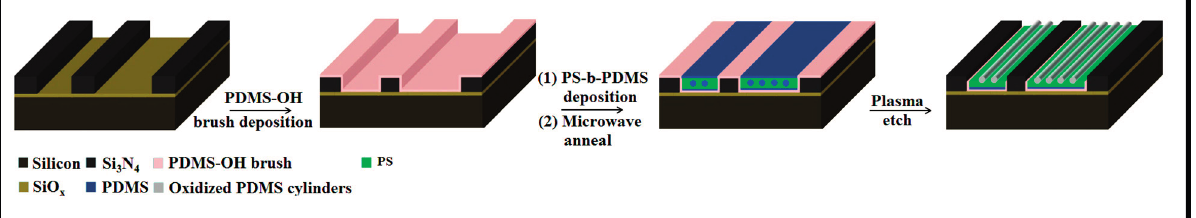
Scheme 2. Schematic representation of the process flow showing BCP directed self-assembly on Si 3 N 4 substrate pre-coated with PDMS-OH brush and subsequent plasma